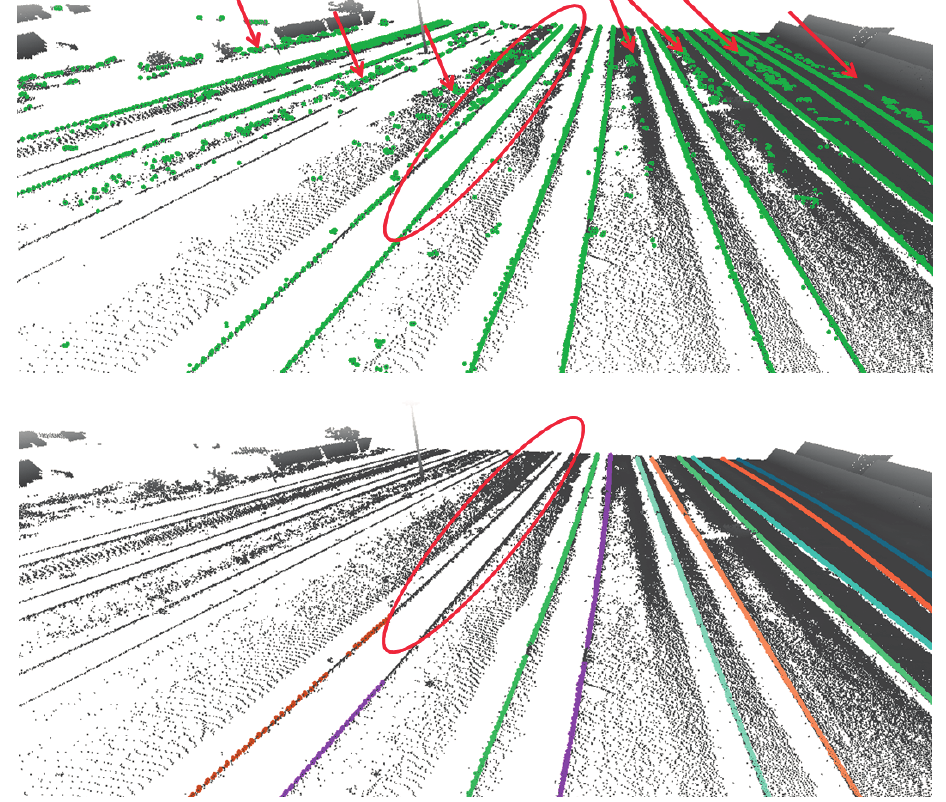
Figure 8. Coarse ( top ) and fine ( bottom ) rail track detection in Blerick. MLS data has been captured at the most right rail